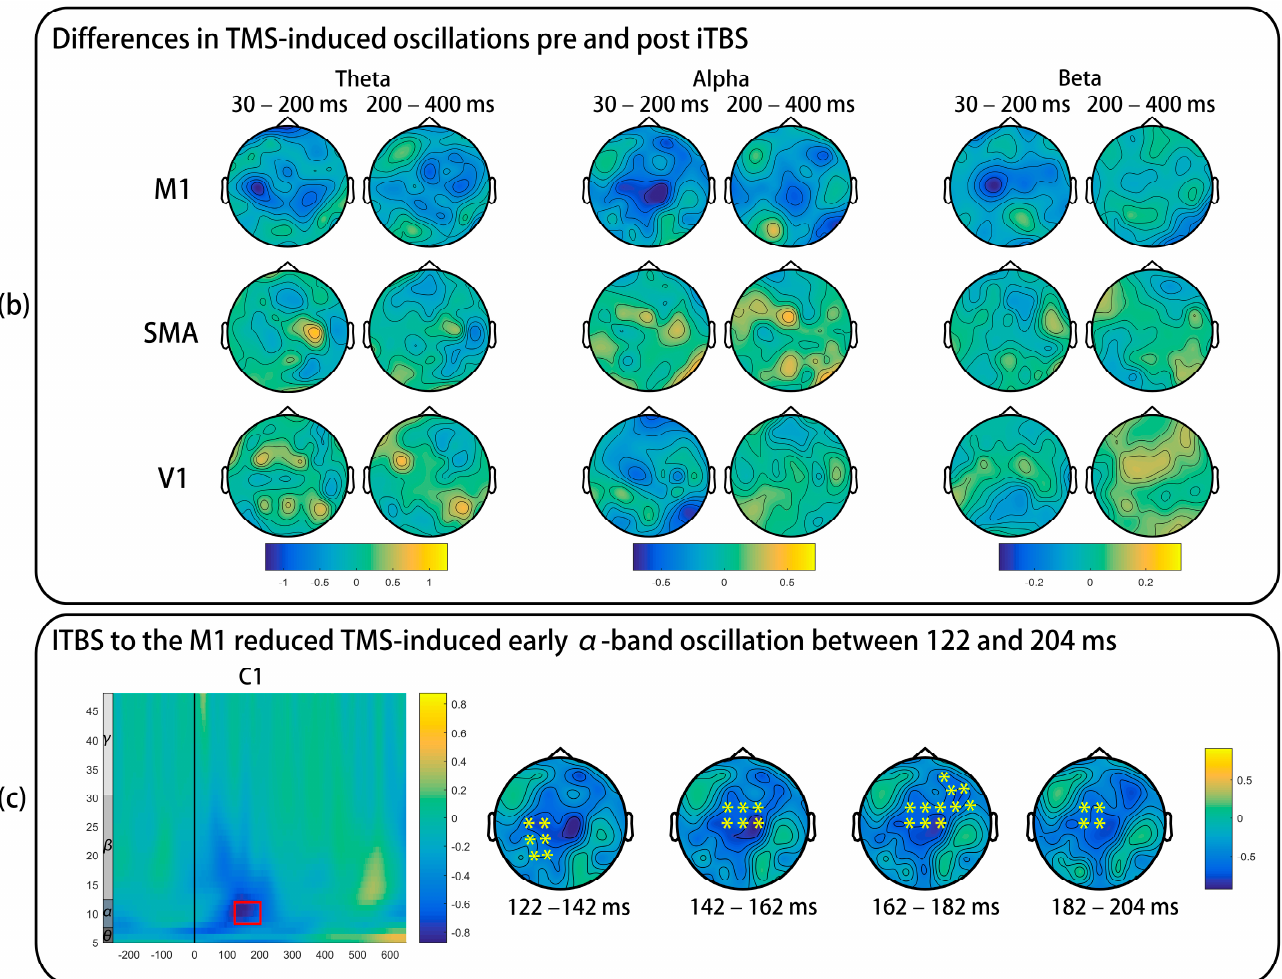
Figure 5. The effect of iTBS in TMS-induced oscillations. The power of each frequency was normalized by dividing all time bins by the mean of baseline power ( − 650 to − 350 ms), and an absolute baseline correction was also carried out. ( a ) Only pre-iTBS data of the M1 condition are presented. ( b ) Topographical plots are the difference of early (30–200 ms) and late (200–400 ms) oscillations. ( c ) The red rectangle indicates significantly decreased TMS-induced early α -band oscillation. “*” represents electrodes with a significant difference. TMS: transcranial magnetic stimulation; iTBS: intermittent theta burst stimulation; M1: primary motor cortex; SMA: supplementary motor area; V1: primary visual cortex.